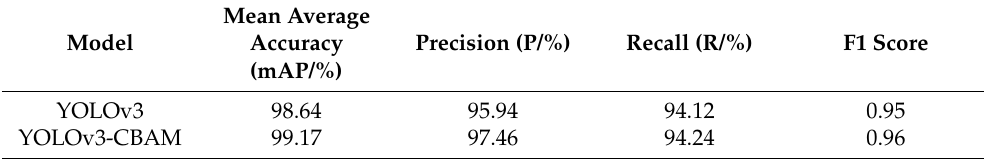
Table 4. Comparison of YOLOv3 and YOLOv3-CBAM.